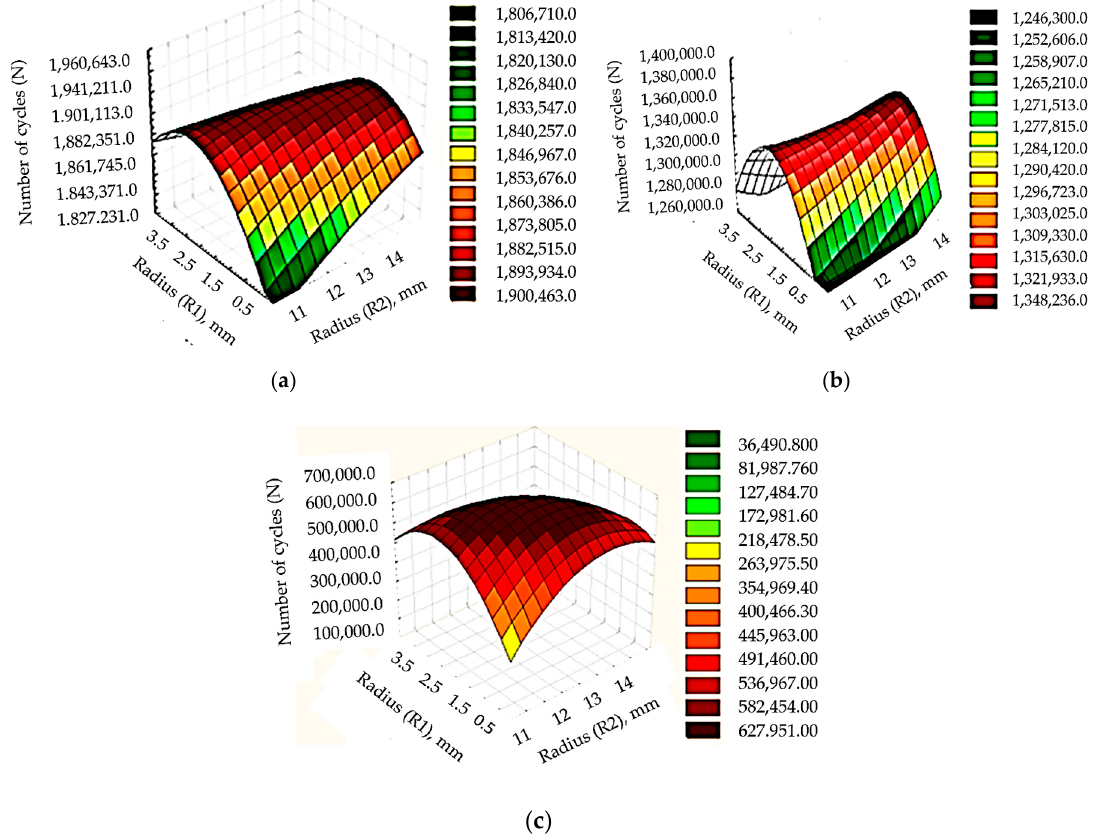
Figure 3. Dependence of the number of stress cycles by the radii R1 and R2 respectively. ( a )—for the load F1 = ±8 kN; ( b )—for the load F2 = ±10 kN; ( c )—for the load F3 = ±12 kN.